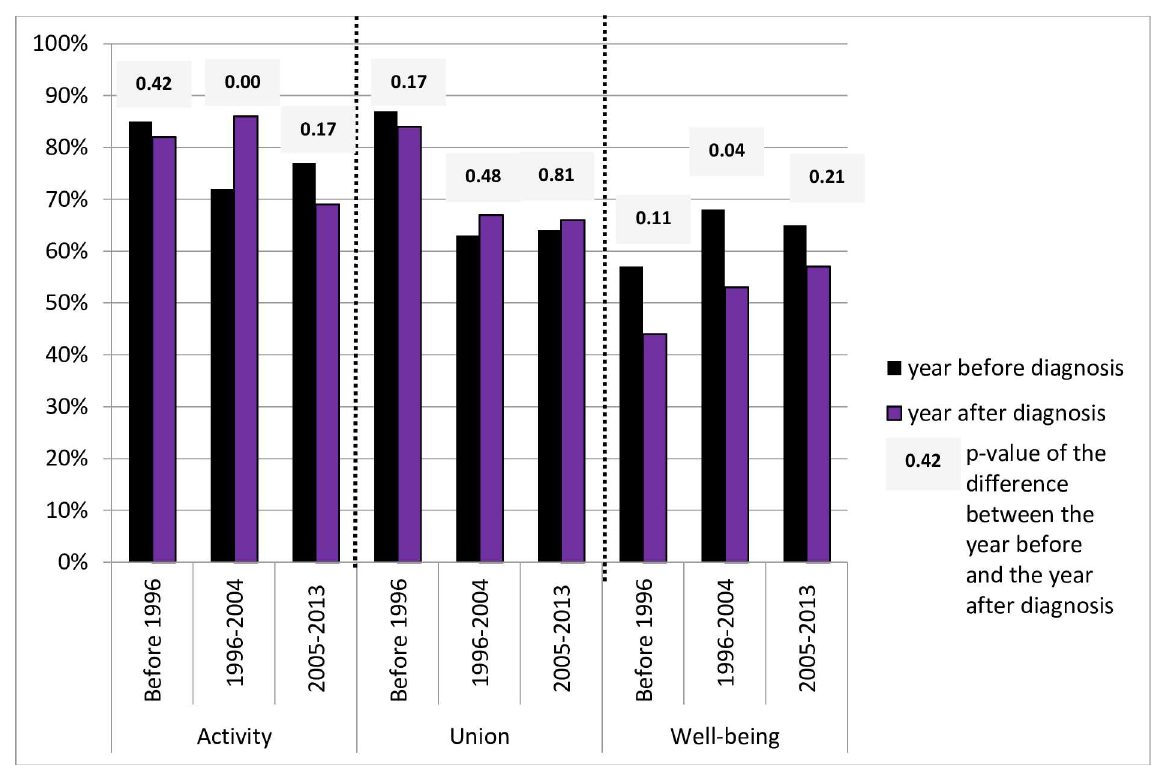
Fig 3. Persons living with HIV: proportion of persons in activity, union and well-being the year before and the year after HIV diagnosis, according to the period of diagnosis (N = 371). Scope: men (N = 142) and women (N = 229) from HIV group who have not yet migratedor being diagnosedat 18 years of age, who are observedat least five years after diagnosisand who were diagnosed in France at least one year after arrival. Source: ANRS Parcours Survey 2012–2013.